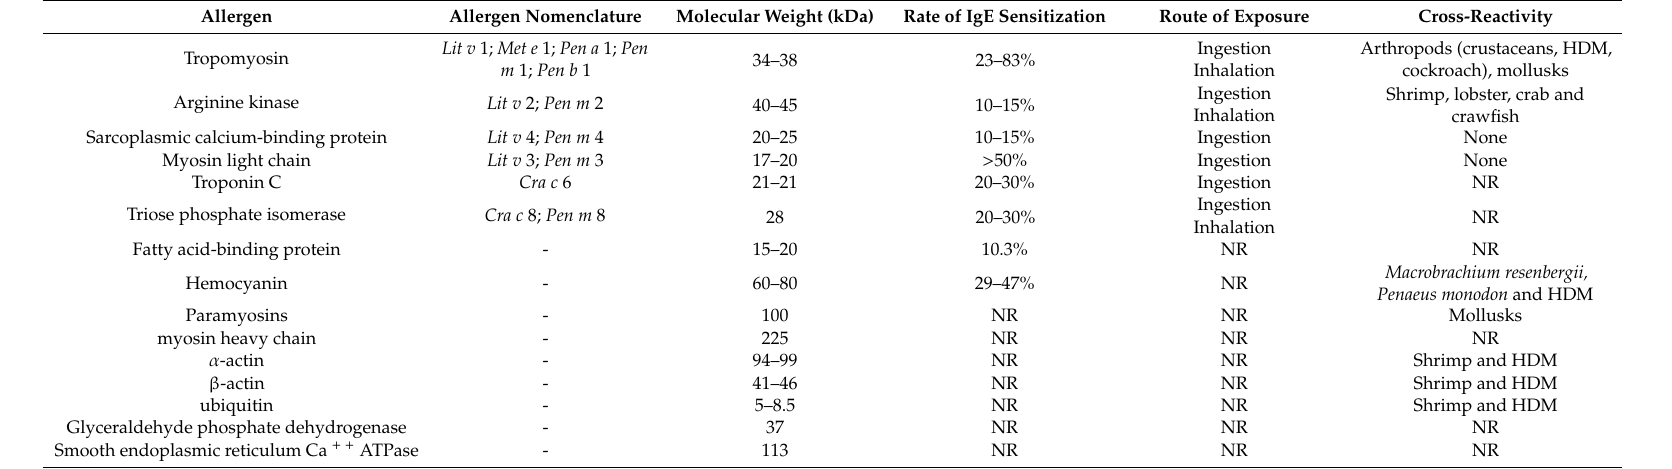
Table 1. List of identified shellfish